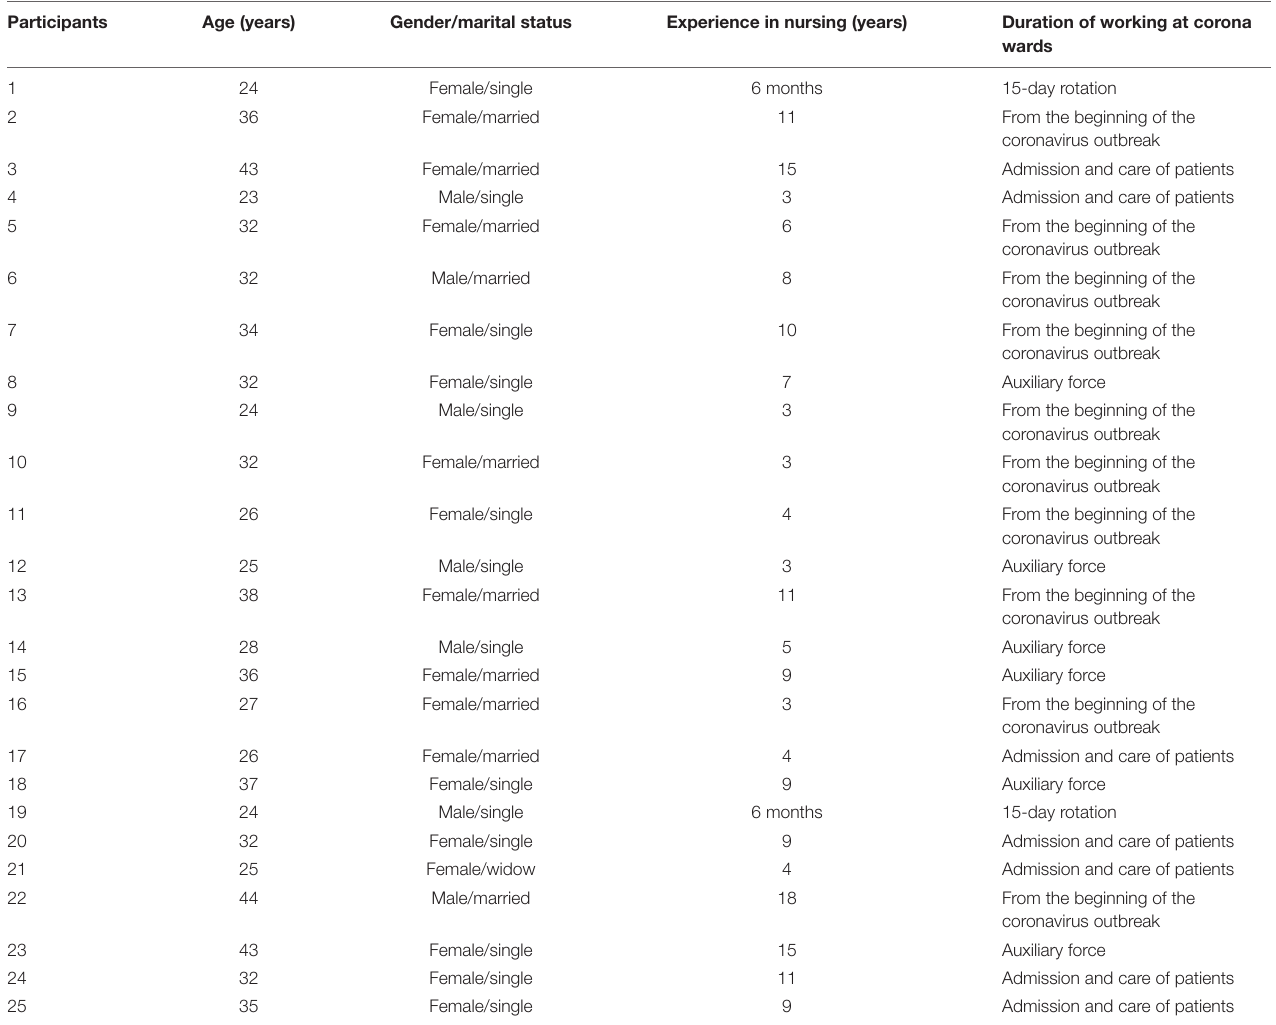
TABLE 1 | Characteristics of participants ( N =